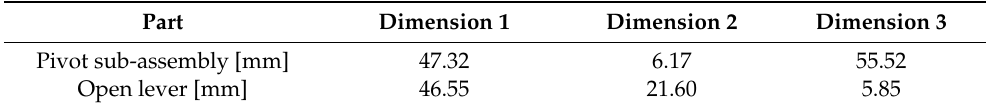
Figure 5. Deflection of the pivot sub-assembly and open lever existing in mass production. ( a ) Pivot sub-assembly. ( b ) Open lever. Table 7. Results of measurement 1, 2, 3 of pivot sub-assembly and open lever existing in mass